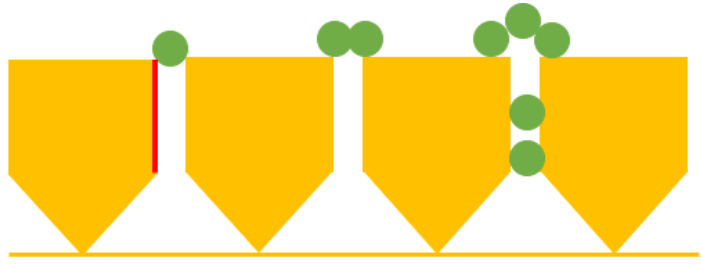
Figure 11. Trapezoidal wire profile and its interaction with particles.